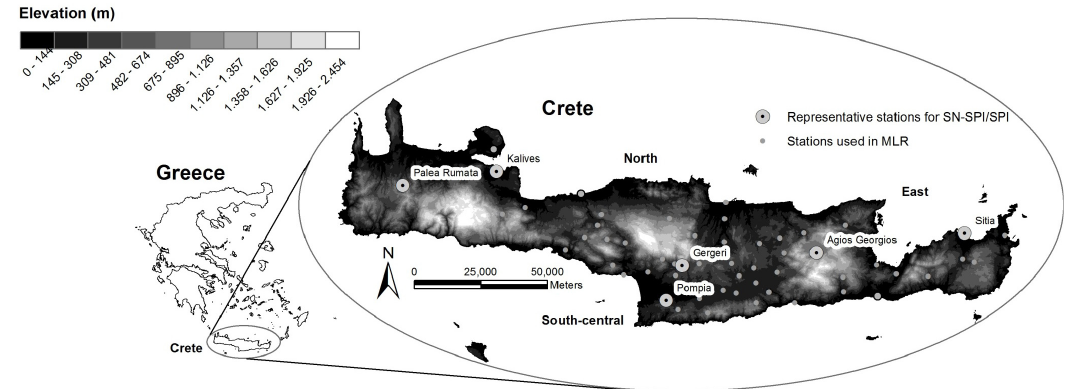
Fig. 1. Area of study, 56 stations used in MLR and 18 representative stations for SPI Crete,